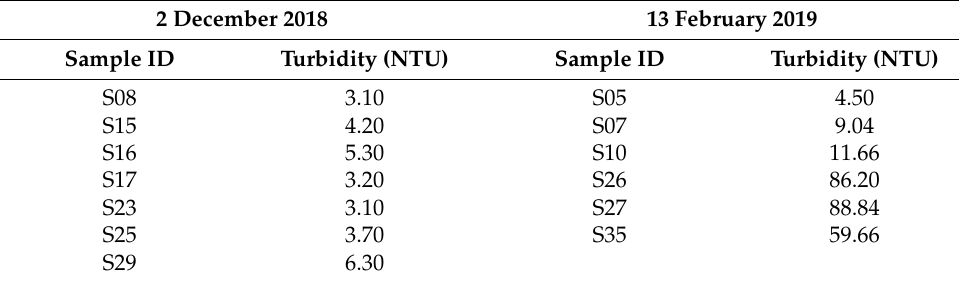
Table 4. Test data for December and February image acquisitions.